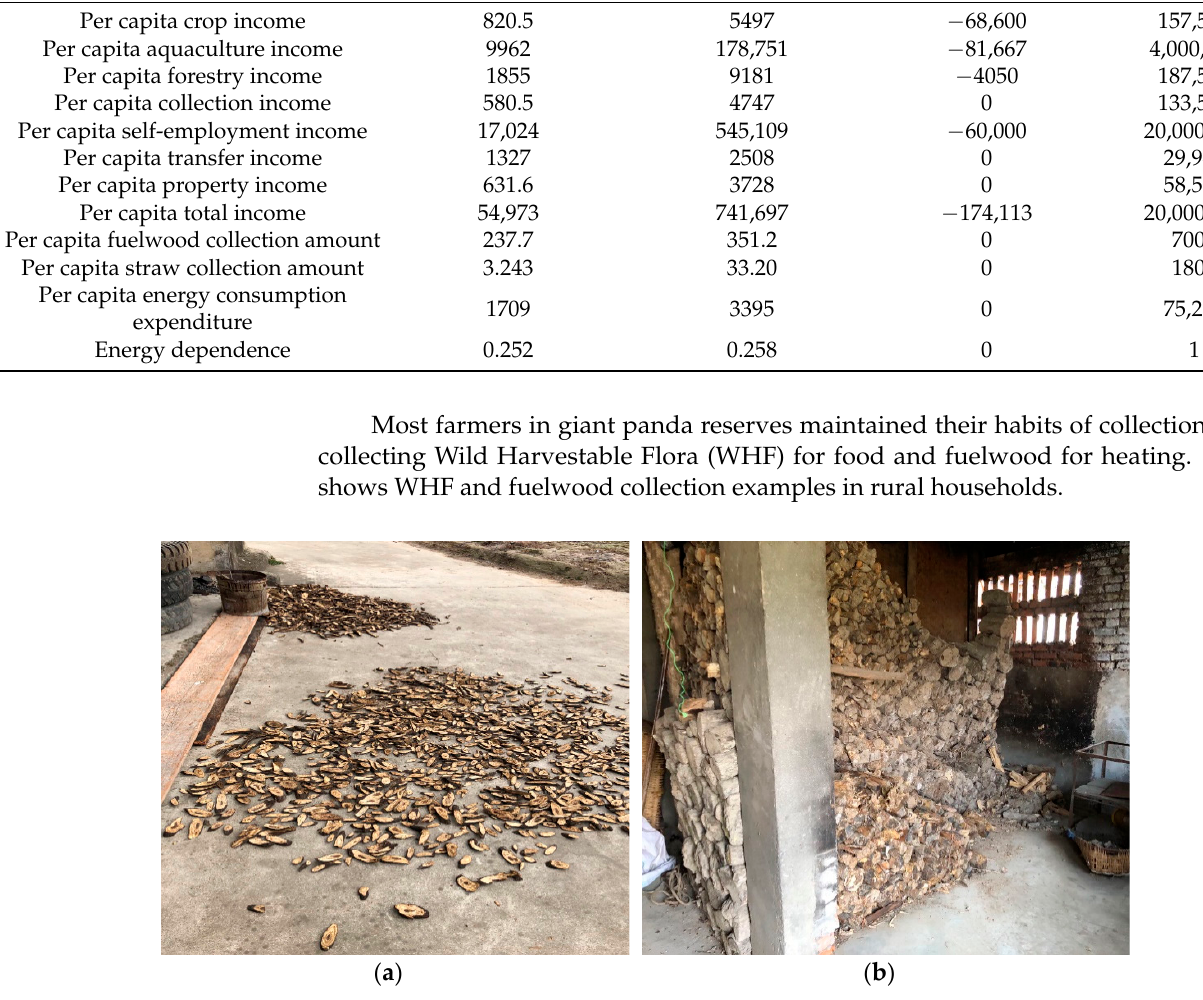
Figure 1. ( a ) Medicinal herbs collected by the household; ( b ) Fuelwood collected by the